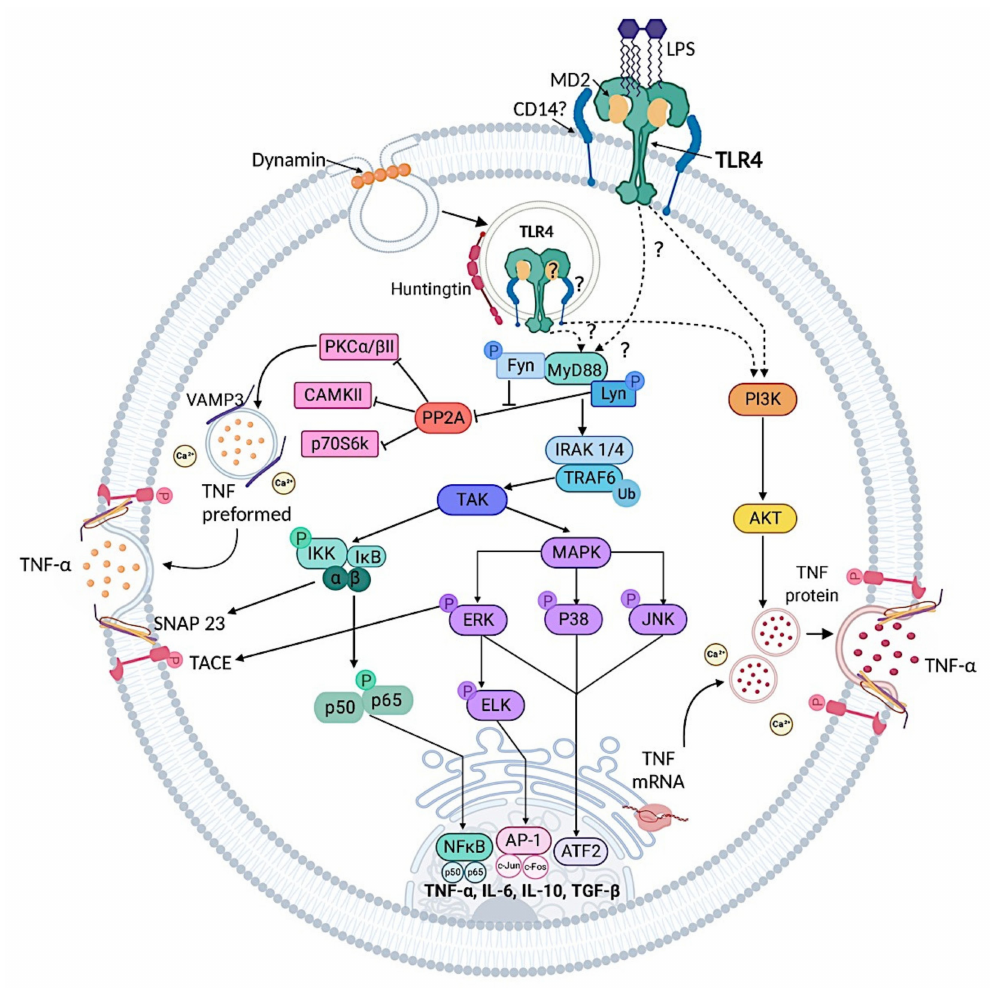
Figure 2. Toll-like 4 receptor signaling in MCs. TLR4 triggering occurs after TLR4 / MD2-complex dimerization. Although CD14 has been detected in MCs at mRNA level, its function in LPS recognition has not been completely elucidated. Signaling from TLR4 receptor on MCs could occur from PM or endosomes, however, internalization-dependent and -independent activation of some elements of the cascade remains to be proven (see text for more references). MyD88-dependent pathway requires the participation of the Src kinases Fyn and Lyn. Lyn induces the activation of IRAK1 / 4, which in consequence activates TRAF6 and TAK1 proteins; on the other hand, Fyn controls PP2A / PKC α / β II axis that negatively regulates signaling. At TAK1, signal bifurcates into the IKK- and the MAPKs- dependent pathways. IKK activates NF κ B transcription factor, which translocates to the nucleus to start production of inflammatory cytokines. On the other hand, phosphorylation of MAPKs activates AP-1 and ATF2, which contribute to inflammatory reactions. Signaling cascades are also linked to secretory control as PKC α / β II regulates VAMP3 + vesicles, IKK phosphorylates SNAP-23, and ERK1 / 2 activates TACE, all of which control TNF- α release. Other molecules have been described to participate in TLR4 signaling such as Ca 2 + , and PI3K / AKT cascade, which also contribute to TNF- α secretion. Figure created with